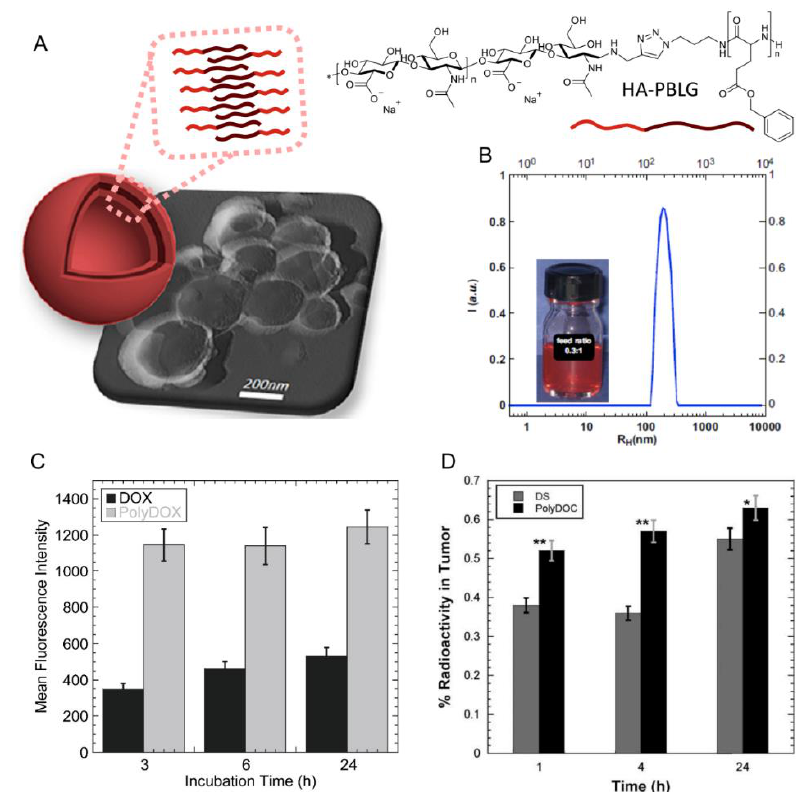
Figure 3. ( A ) Schematic representation and TEM imaging of the prepared polymersomes. ( B ) DLS size distribution of DOX loaded polymersomes (PolyDOX). Insert is a photo of a PolyDOX solution ( C ) represent DOX and PolyDOX uptake in MCF-7 cells at 10 mM DOX concentration ( D ) Tumor uptakes of 99m Tc labelled-DOC solution (DS) and 99m Tc labelled-PolyDOC (both at 2 mg/kg mice). Each point represents the mean of three mice ± S.D. (* p < 0.05 vs. DS, ** p < 0.001 vs. DS). The results are expressed as the mean ± SD ( n = 3). Adapted with permission from [28,29]. Copyright 2019, John Wiley and Sons and Elsevier, respectively.